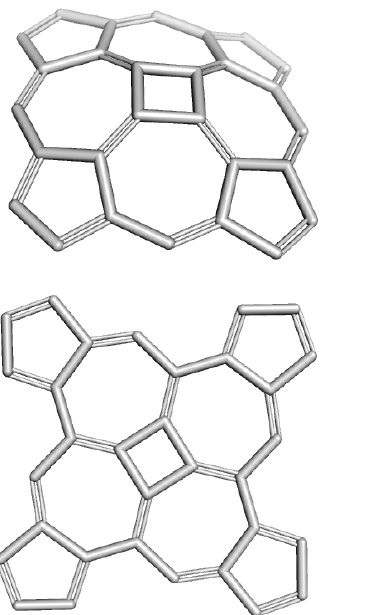
Table 1. The total energies E Compound Symmetry E